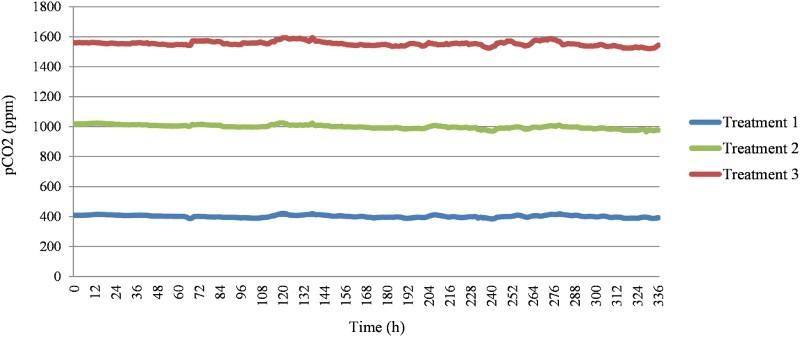
Values of pCO2 monitored in each treatment during the experimental period of 14 days.